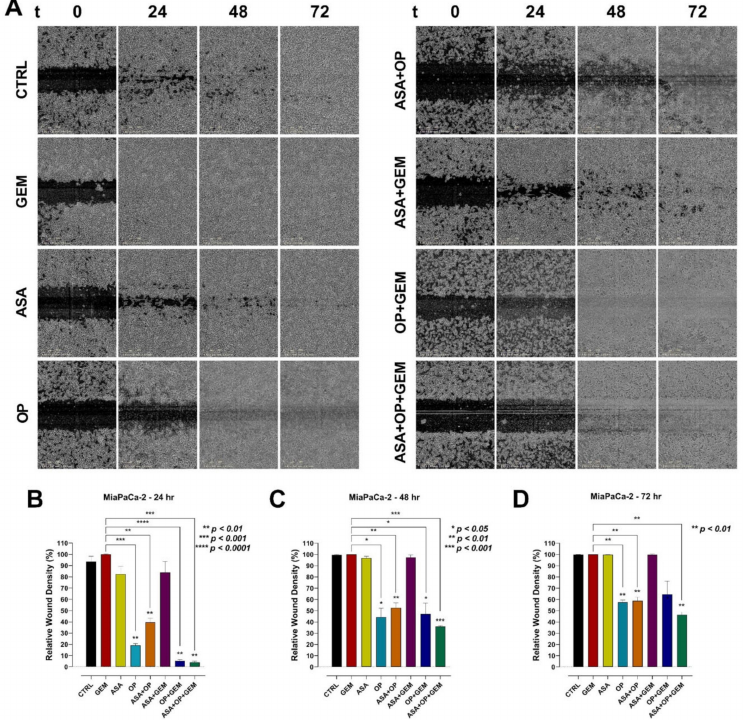
Figure 9. ASA, OP, GEM, and their combination inhibit wound closure of MiaPaCa-2 pancreatic cancer cells. MiaPaCa-2 cells were seeded in a flat bottom ImageLock™ 96-well plate and allowed to adhere overnight. The WoundMaker™ was used to create reproducible wounds in all wells. Unbound cells were washed, and cells were treated with ASA (0.7 mM), OP (3.5 mM), GEM (0.285 µ M), or their combination. ( A ) The IncuCyte ZOOM ® software was used to scan the plate repeatedly over 72 h. The wound migration area was quantified using the IncuCyte ZOOM ® software comparing the wound density at ( B ) 24 h, ( C ) 48 h, and ( D ) 72 h to the immediate wound density. The data are presented as relative wound density ± SEM of 3 independent experiments performed in triplicates. Significance is shown compared to the CTRL unless otherwise shown. Abbreviations: ASA, aspirin; OP, oseltamivir phosphate; GEM, gemcitabine; SEM, standard error of the mean; CTRL,